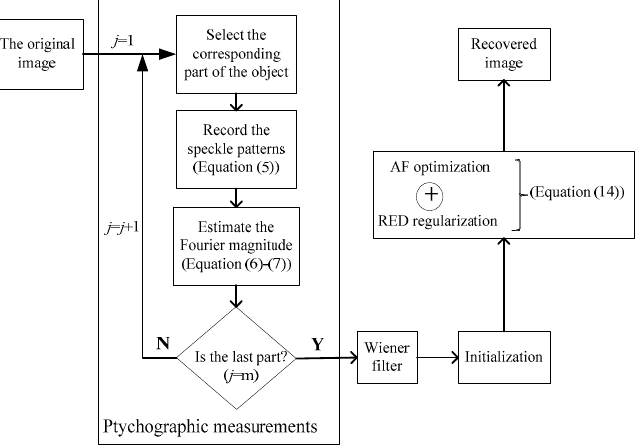
Figure 7. The data processing flow chart for ptychographic imaging correlography. Note: AF = amplitude flow; RED = regularization by denoising.